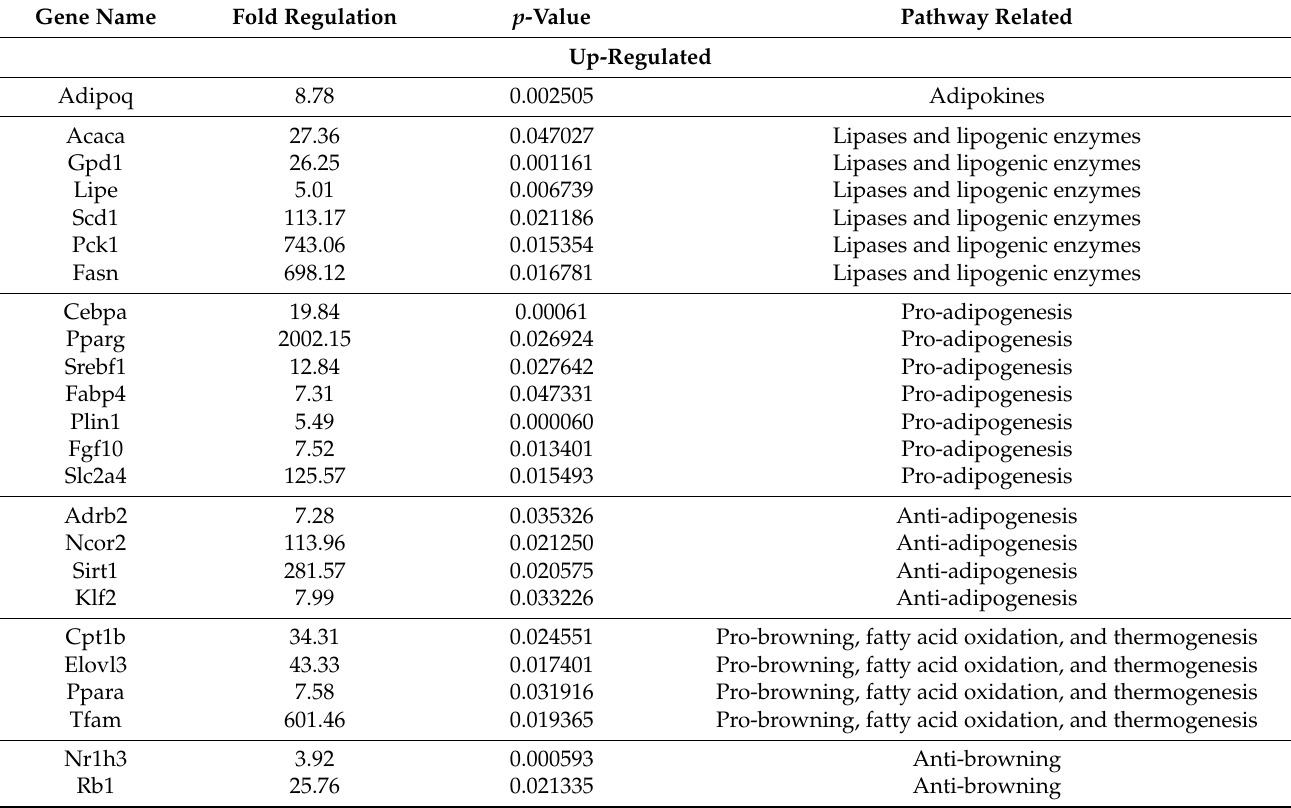
Figure 3. GbE increased the lipid content evaluated by Oil Red O staining after the treatment of 3T3-L1 cells with GbE in different concentrations (0.75 and 1.00 mg/mL) during the differentiation process (7 days), and control group. The values were normalized to the average of control group levels. Results are expressed as mean ± SEM ( n = 6) from three independent experiments. One-way ANOVA followed by Dunnett’s post-test. * p < 0.05 vs. control. Table 1. Genes modulated by GbE treatment during the differentiation process (D7) in 3T3-L1 cells. GbE treatment during the differentiation process (7 days) modulated the gene expression of different main markers of lipid metabolic pathways in 3T3-L1 cells. The data were obtained using PCR Array Gene Expression Assay. ( n = 3) from one independent experiment. p < 0.05 vs.